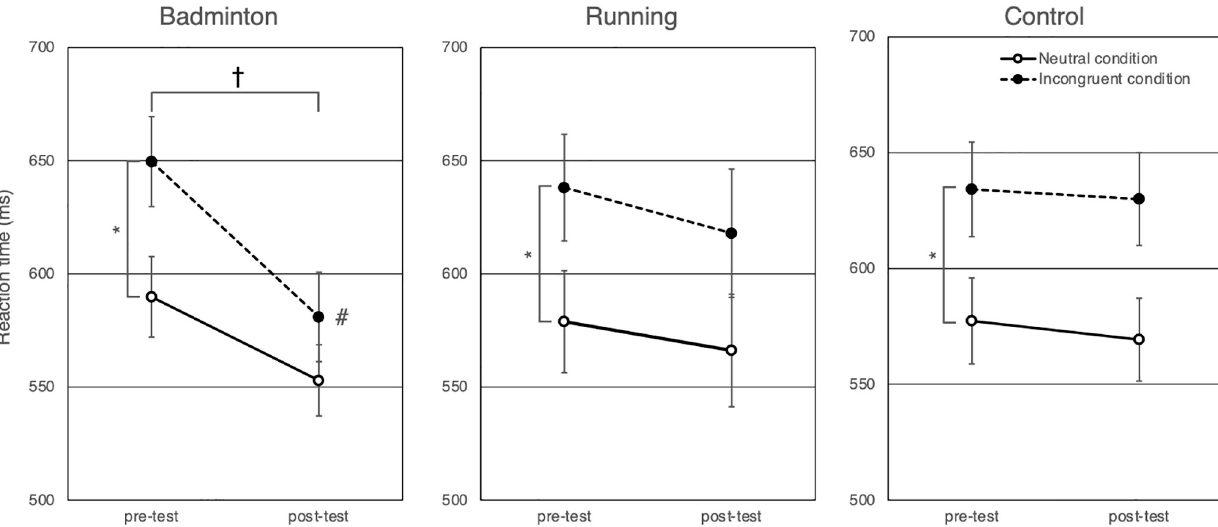
Fig 3. Comparisons of the reaction time for each intervention. Solid lines with white circles represent changes in the reaction time for the neutral condition. Broken lines with black circles represent changes in the reaction time for the incongruent condition. Error bars show the standard errors of the mean. For the badminton intervention, the reaction time for both neutral and incongruent conditions was shortened, and the decrease in the reaction time for the incongruent condition was more pronounced than for the neutral condition. Changes between pre-test and post-test were not significant for running and control interventions. � means the significant difference between the neutral condition and the incongruent condition ( p < .05), † means the significant difference between pre-test and post-test ( p < .05), and # means that the reaction time for the incongruent condition was significantly shortened than that for the neutral condition ( p <